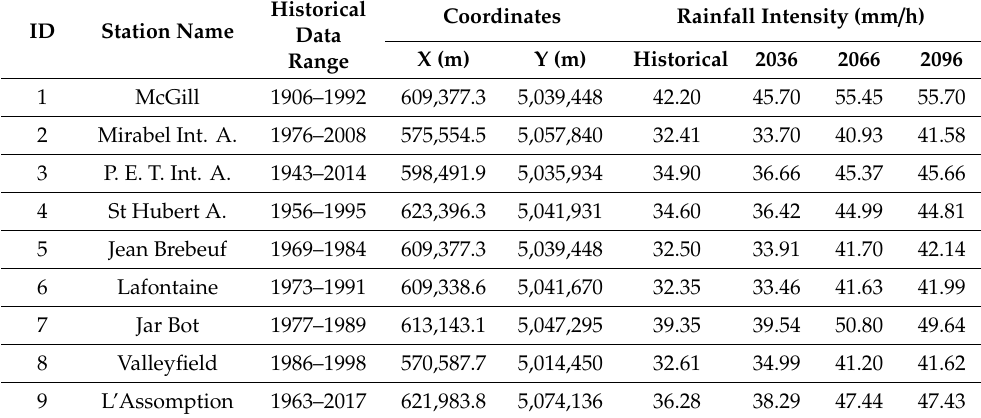
Table 2. Projected rainfall intensity for Montreal for Scenarios 2036, 2066, and 2096, 60 min duration [51], and 10-year RP. The coordinates are in NAD_1983_UTM_Zone_18N.